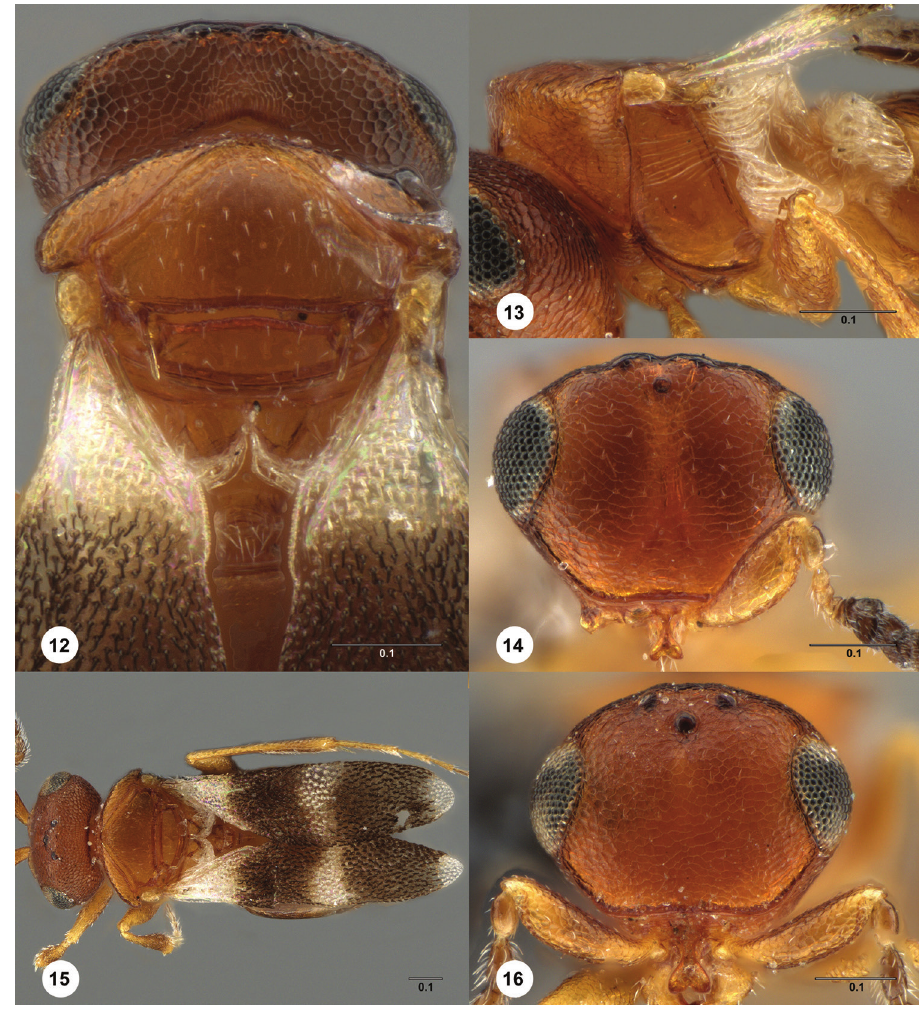
Figures 12–16. Pulchrisolia asantesana , female holotype (SAM-HYM-P046628) 12 head, mesosoma, T1, T2, dorsal view 13 head, mesosoma, S1, lateral view 14 head, anterior view 15 male paratype (SAM- HYM-P046628), head, mesosoma, metasoma, dorsal view 16 head, anterior view. Scale bars in millimeters. late. Sculpture of mesoscutellum: absent. Setation of anterodorsal metapleuron: pre- sent. Length of setation of anterodorsal metapleuron: long. Setation of anteroventral metapleuron: absent. Foamy structures on anterior metapleuron: absent. Shape of fore wing: oblong. Infuscate banding of fore wing: present. Costal margin of hind wing: darkly sclerotized posterior to hamuli. Marginal cilia of female fore wing: absent. Diagnosis. The straight frontal ledge and short fore wings with dense microtrichia readily separate this species from other Pulchrisolia